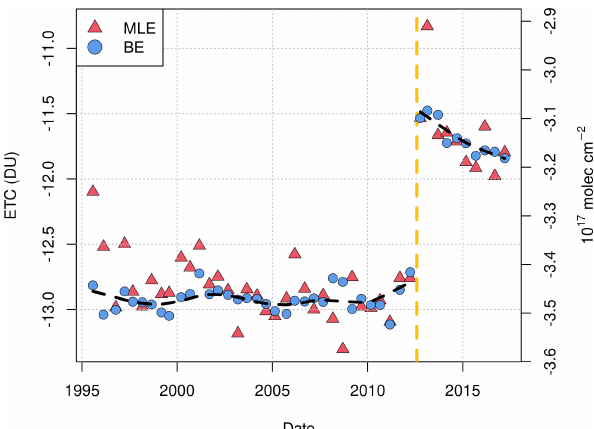
Figure 2. Extraterrestrial coefficients of Brewer #067 determined with minimum-amount Langley extrapolation (MLE, triangles) and bootstrap estimation (BE, circles). The vertical yellow line indi- cates the discontinuity occurring in correspondence of the Arosa campaign in July 2012 (Sect. 2.2.1). The dashed black line repre- sents a LOESS interpolation through the ETCs estimated by the BE